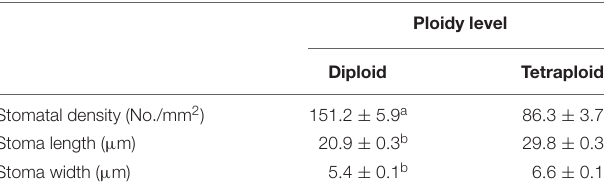
TABLE 3 | Stomata size ( n = 24) and density ( n = 8) of diploid and tetraploid leaves of Magnolia officinalis